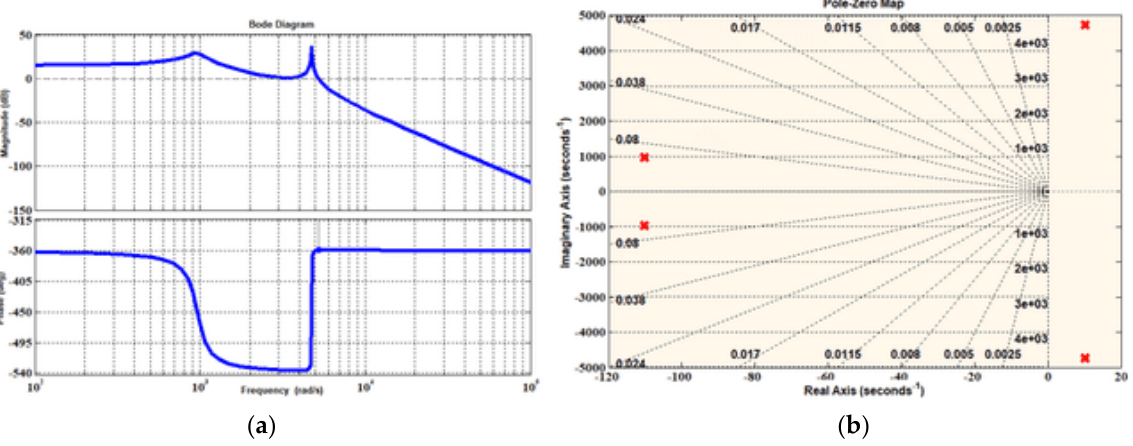
Figure 9. Dynamic analysis ( a ) bode plot of input to output transfer function; ( b ) pole-zero map of input to output transfer function.